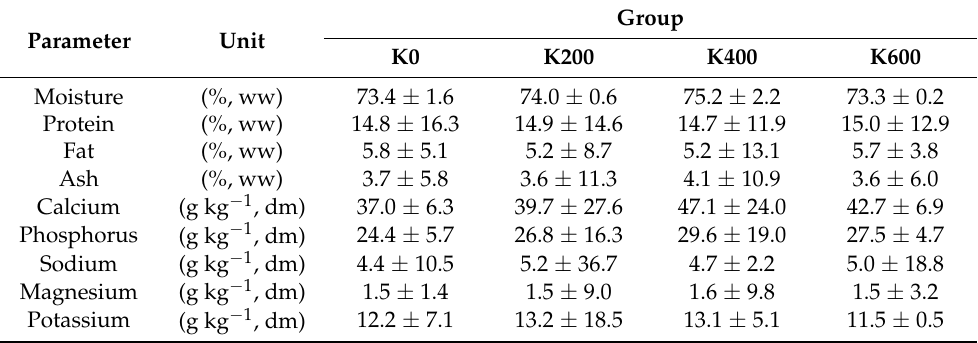
Table 4. Final proximate compositions and mineral contents in whole fish of C. gariepinus ( n = 3, each sample of 8 pooled fish) (mean ± CV). Final sampling was performed on day